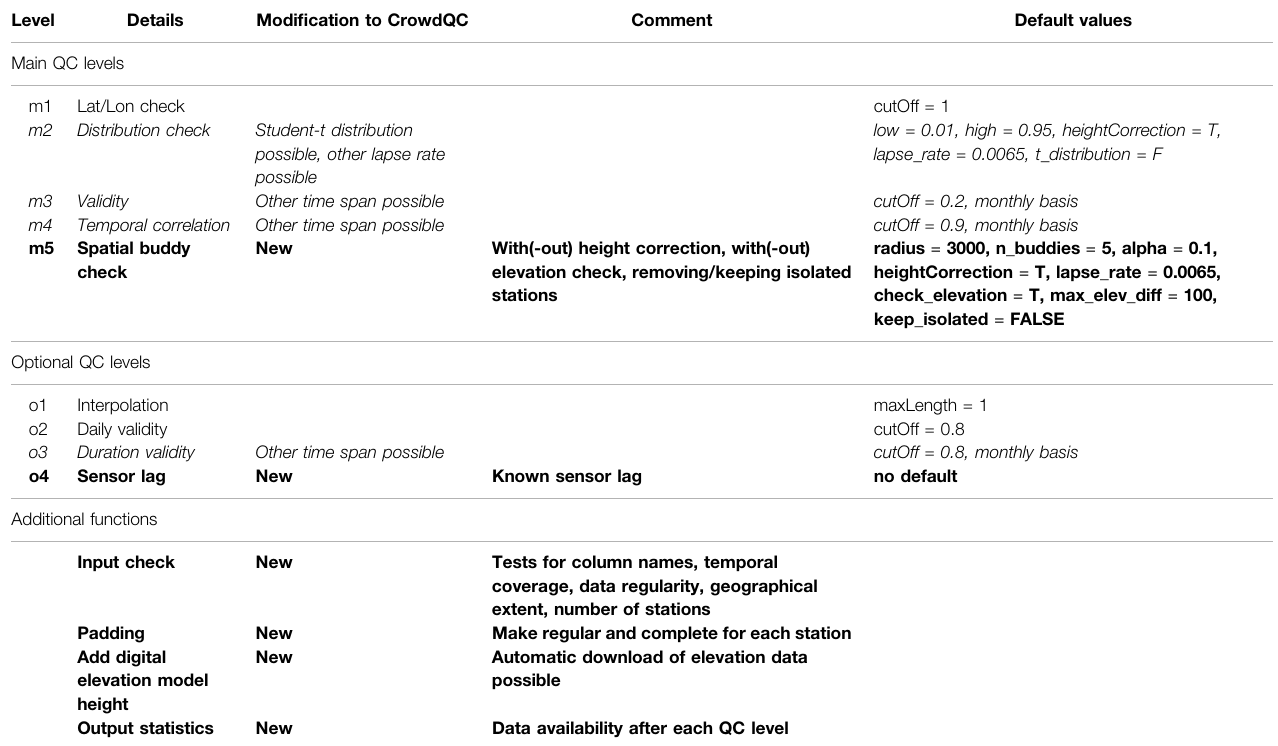
TABLE2| OverviewofthequalitycontrolQClevelsandadditionalfunctionsavailableinCrowdQC+.Italiclinesmarkfunctionsthatweremodi fi edregardingtheirfunctionality compared to the original CrowdQC, bold lines mark functions that were added in